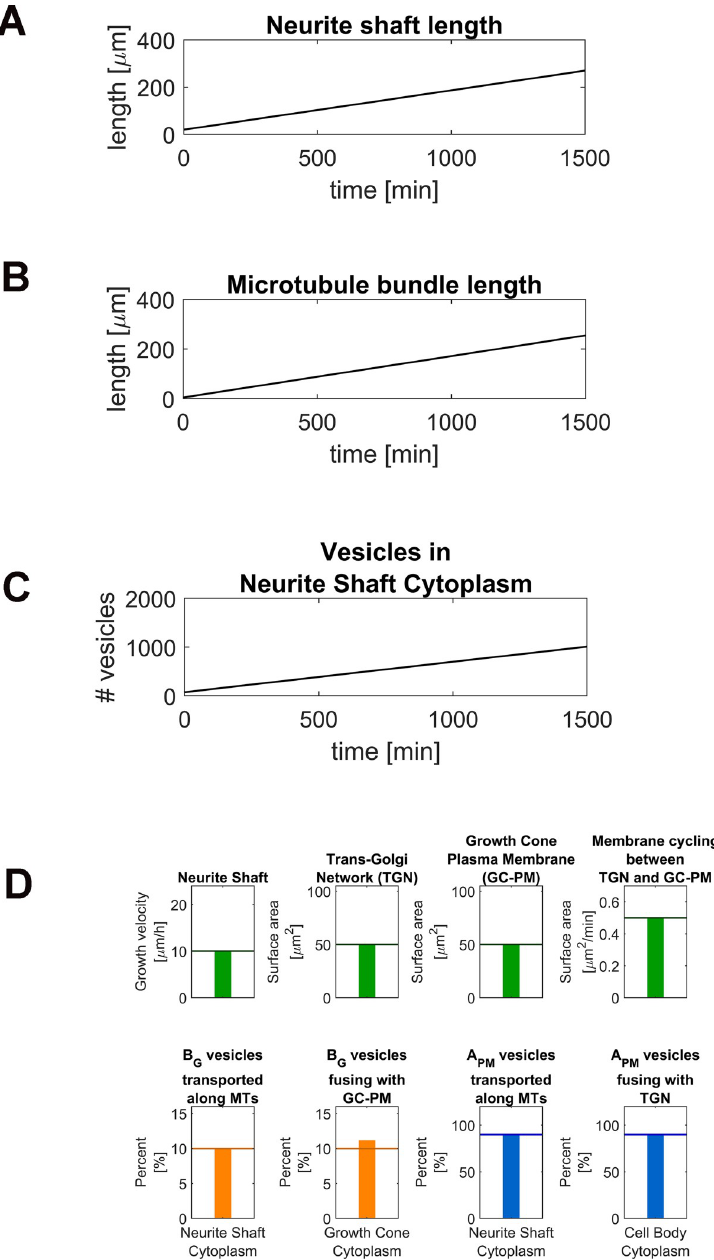
Fig 4. Simulation of vesicle transport and microtubule growth during neurite outgrowth. (A-B) We identified a set of kinetic parameters (S7 Table) that allows neurite outgrowth via coordinated neurite shaft (A) and microtubule bundle growth (B) with a velocity of 10 μ m/h. (C) The growing neurite shaft cytoplasm (NSC) within the growing neurite acts as a sink for anterograde and retrograde vesicles, causing an accumulation of vesicles within this compartment. (D) Our identified set of kinetic parameters allows NOG without violation of the model constraints that we selected to define physiological outgrowth